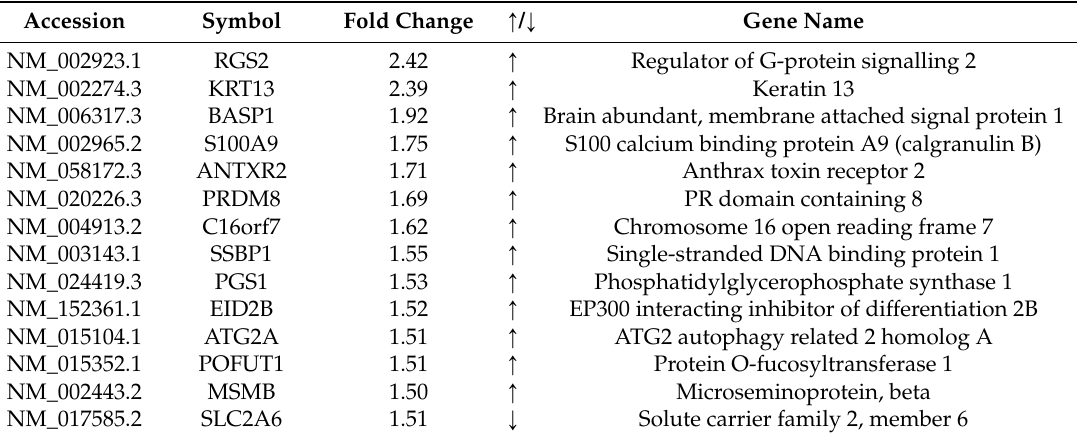
Table 4. The differentially expressed genes in sputum from healthy controls at 4 h post-meal compared with baseline with a fold change greater than 1.5 and direction of change in regulation.